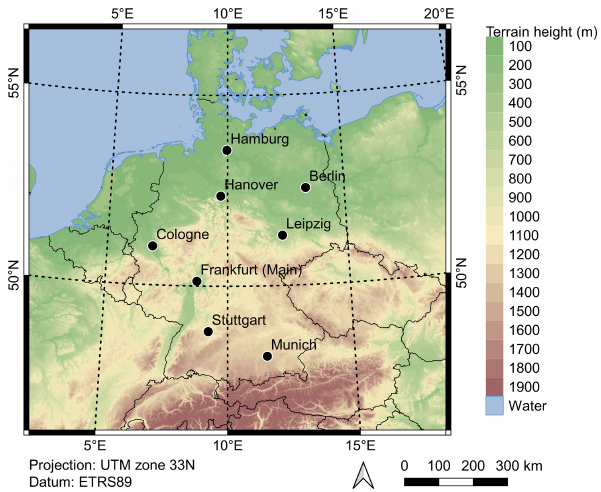
Figure 1. Location of investigated cites. Topographic map is based on GTOPO30 data retrieved from European Environment Agency (EEA,